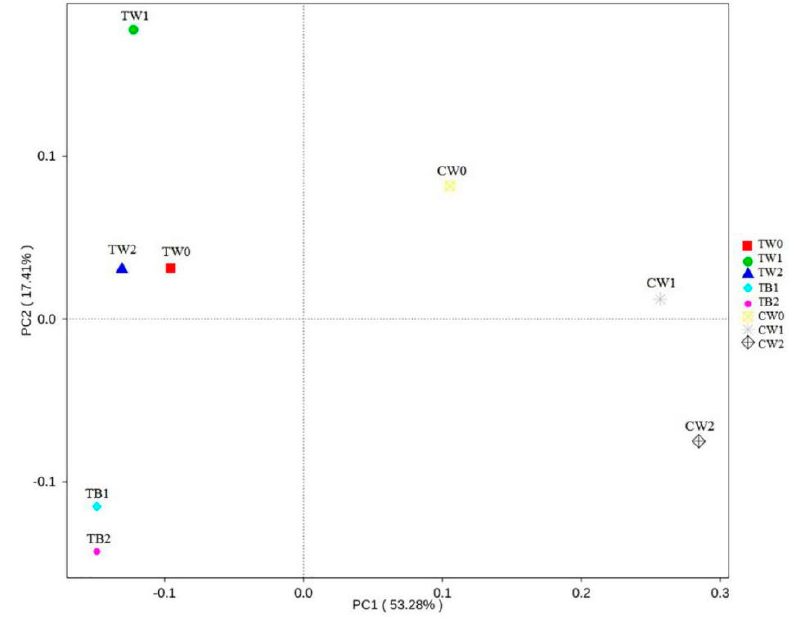
Figure 6. Coordinates analysis (PCoA) based on the weighted UniFrac distance of 16S rRNA genes.